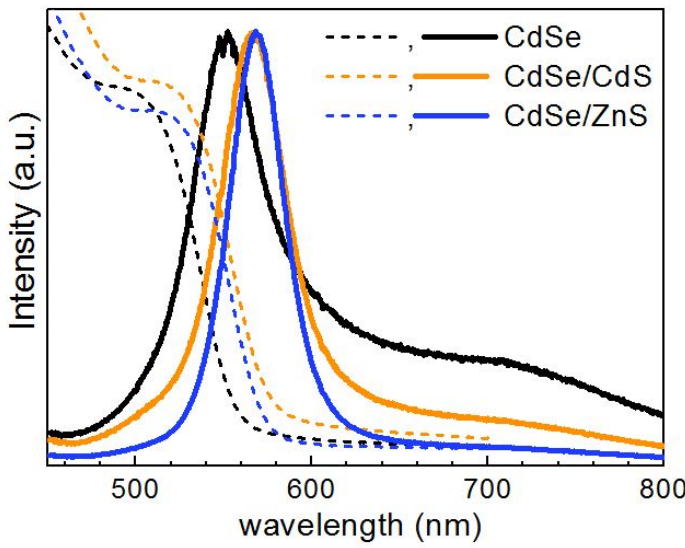
Figure 1. Representative optical absorption (dashed lines) and photoluminescence (PL) (solid lines, λ exc = 325 nm) of a series of about 3nm CdSe NCs and 4 nm core/shell NCs in gelatin matrix.